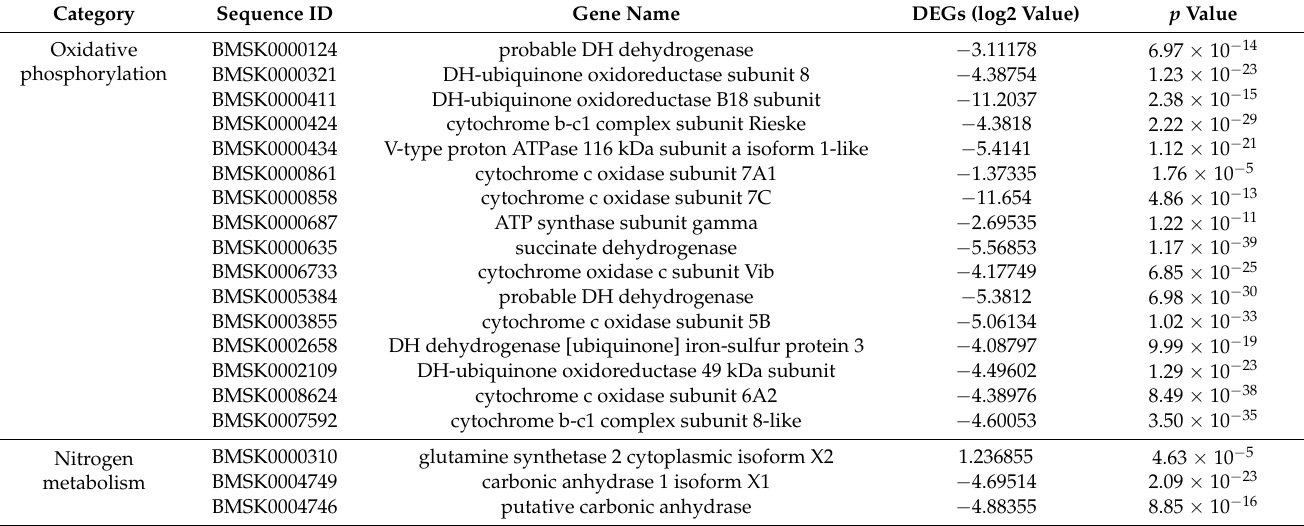
Table 2. Classification of DEGs involved in host energy and nutrient